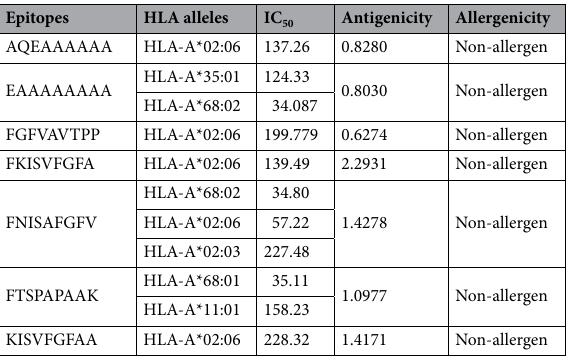
Table 2. Final predicted CD 8 + T cells epitopes, 100 overlapped with CD4 + T cell epitopes and interacting with different MHC-I